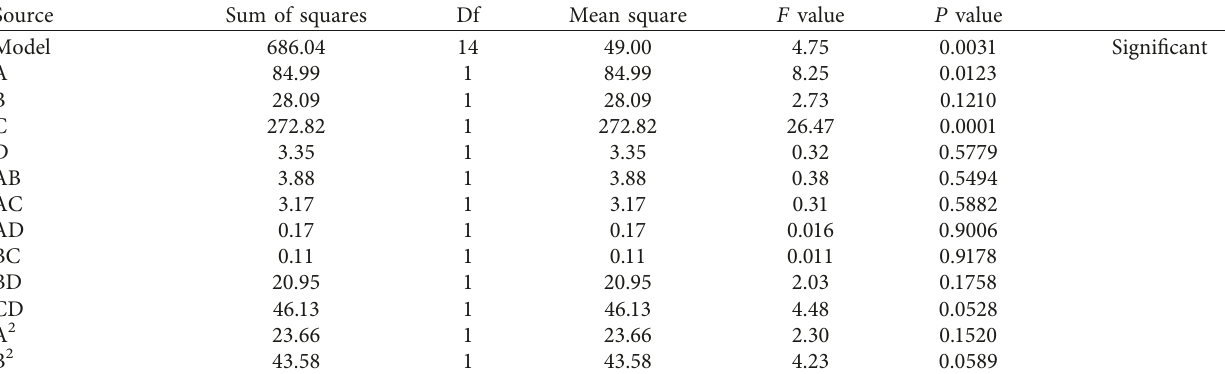
Table 5: Results of variance analysis of PcS extraction process response surface